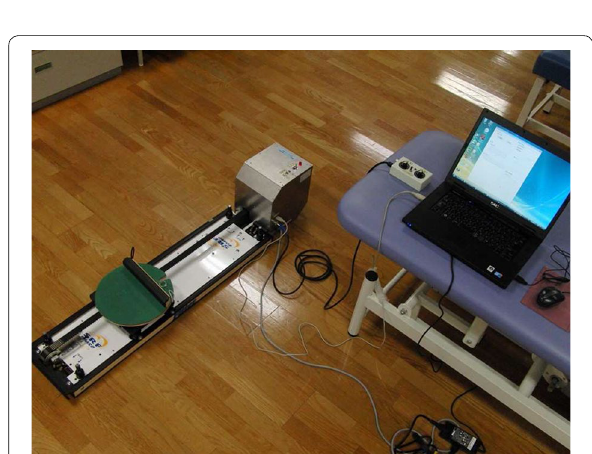
Fig. 6 Prototype of the isokinetic exercise device for the lower limbs, ERIK